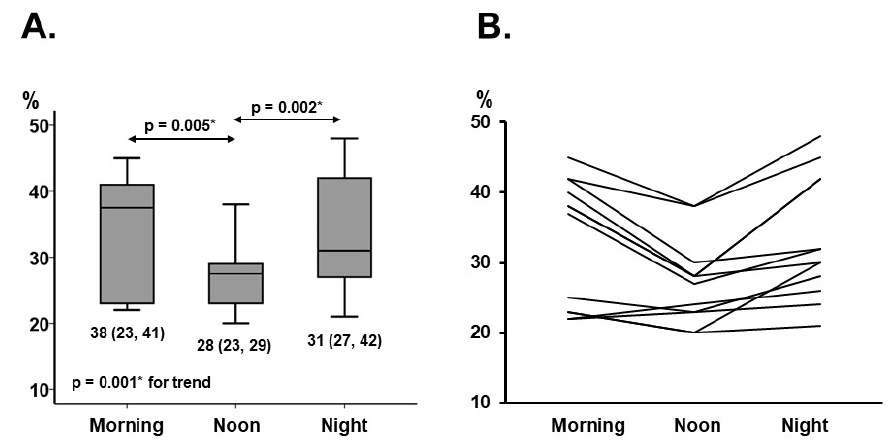
Figure 2. Trends of ReDS values during the day expressed as median values ( A ) and individual absolute values ( B ). Trends were assessed using Friedman test and post-hoc Wilcoxon signed-rank test. * p < 0.05.